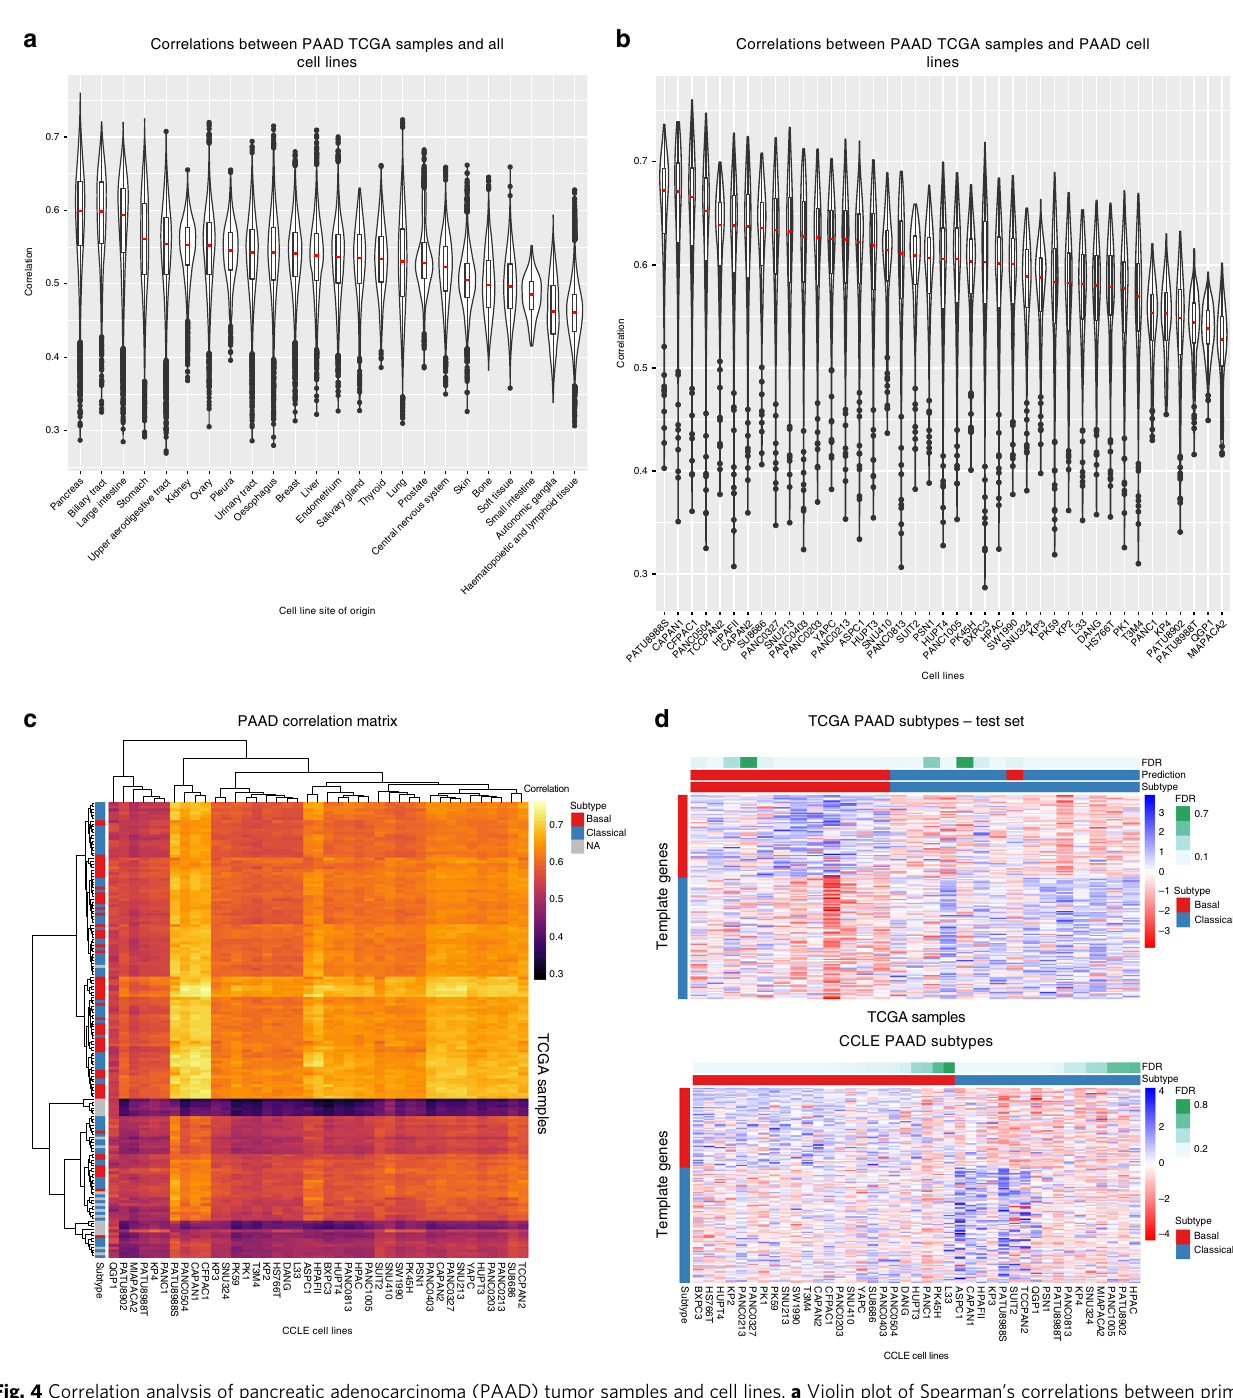
Fig. 4 Correlation analysis of pancreatic adenocarcinoma (PAAD) tumor samples and cell lines. a Violin plot of Spearman ’ s correlations between primary PAAD samples and all CCLE cell lines using 5000 most variable genes. The correlations are separated by cell line tissue of origin ( x -axis). In the overlaid boxplot, the red center line depicts the median, the box limits depict the upper and lower quartiles, and the whiskers depict 1.5 times the interquartile range (IQR). Primary pancreatic tumor samples are most correlated with cell lines from the pancreas followed by the biliary tract. b Violin plot of Spearman ’ s correlations between PAAD cell lines and PAAD tumor samples, separated by cell lines ( x -axis). The median correlation coef fi cients, which are depicted by the red lines, range from 0.67 to 0.49. In the overlaid boxplot, the box limits depict the upper and lower quartiles, and the whiskers depict 1.5 times the IQR. c Heatmap showing the Spearman ’ s correlations between PAAD cell lines ( x -axis) and PAAD primary tumor samples ( y -axis). The color bar on the y -axis indicates the subtype of the TCGA primary tumor samples. d Heatmaps show the expression levels of the PDAC template genes for the basal and classical PAAD subtypes. Top graph shows the TCGA PAAD test set with annotation color bars showing actual subtype, predicted subtype, and FDR for the subtype predictions. Bottom graph shows PAAD cell lines with annotation color bars showing predicted subtype and FDR for the subtype